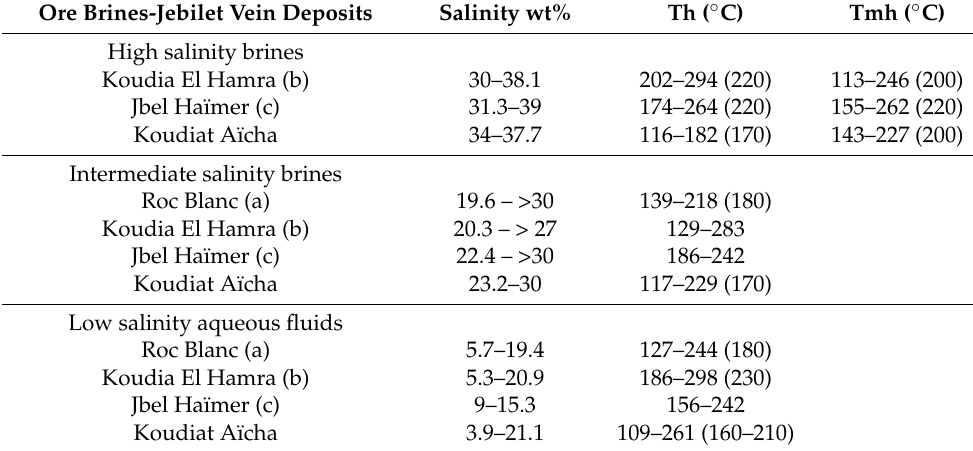
Table 6. Comparison of microthermometric data for ore brines and low-salinity aqueous FIs from late vein stages at Koudiat Aïcha (stage III in bold font) with data for high- to low-salinity aqueous ore fluids from vein deposits in the Central Jebilet: a: Roc Blanc Ag deposit [20]; b: Koudia El Hamra Ag deposit [21]; c: Jbel Haïmer Cu occurrences [22]. Th and Tm h modes in brackets. Ore Brines-Jebilet Vein Deposits Salinity wt% High salinity